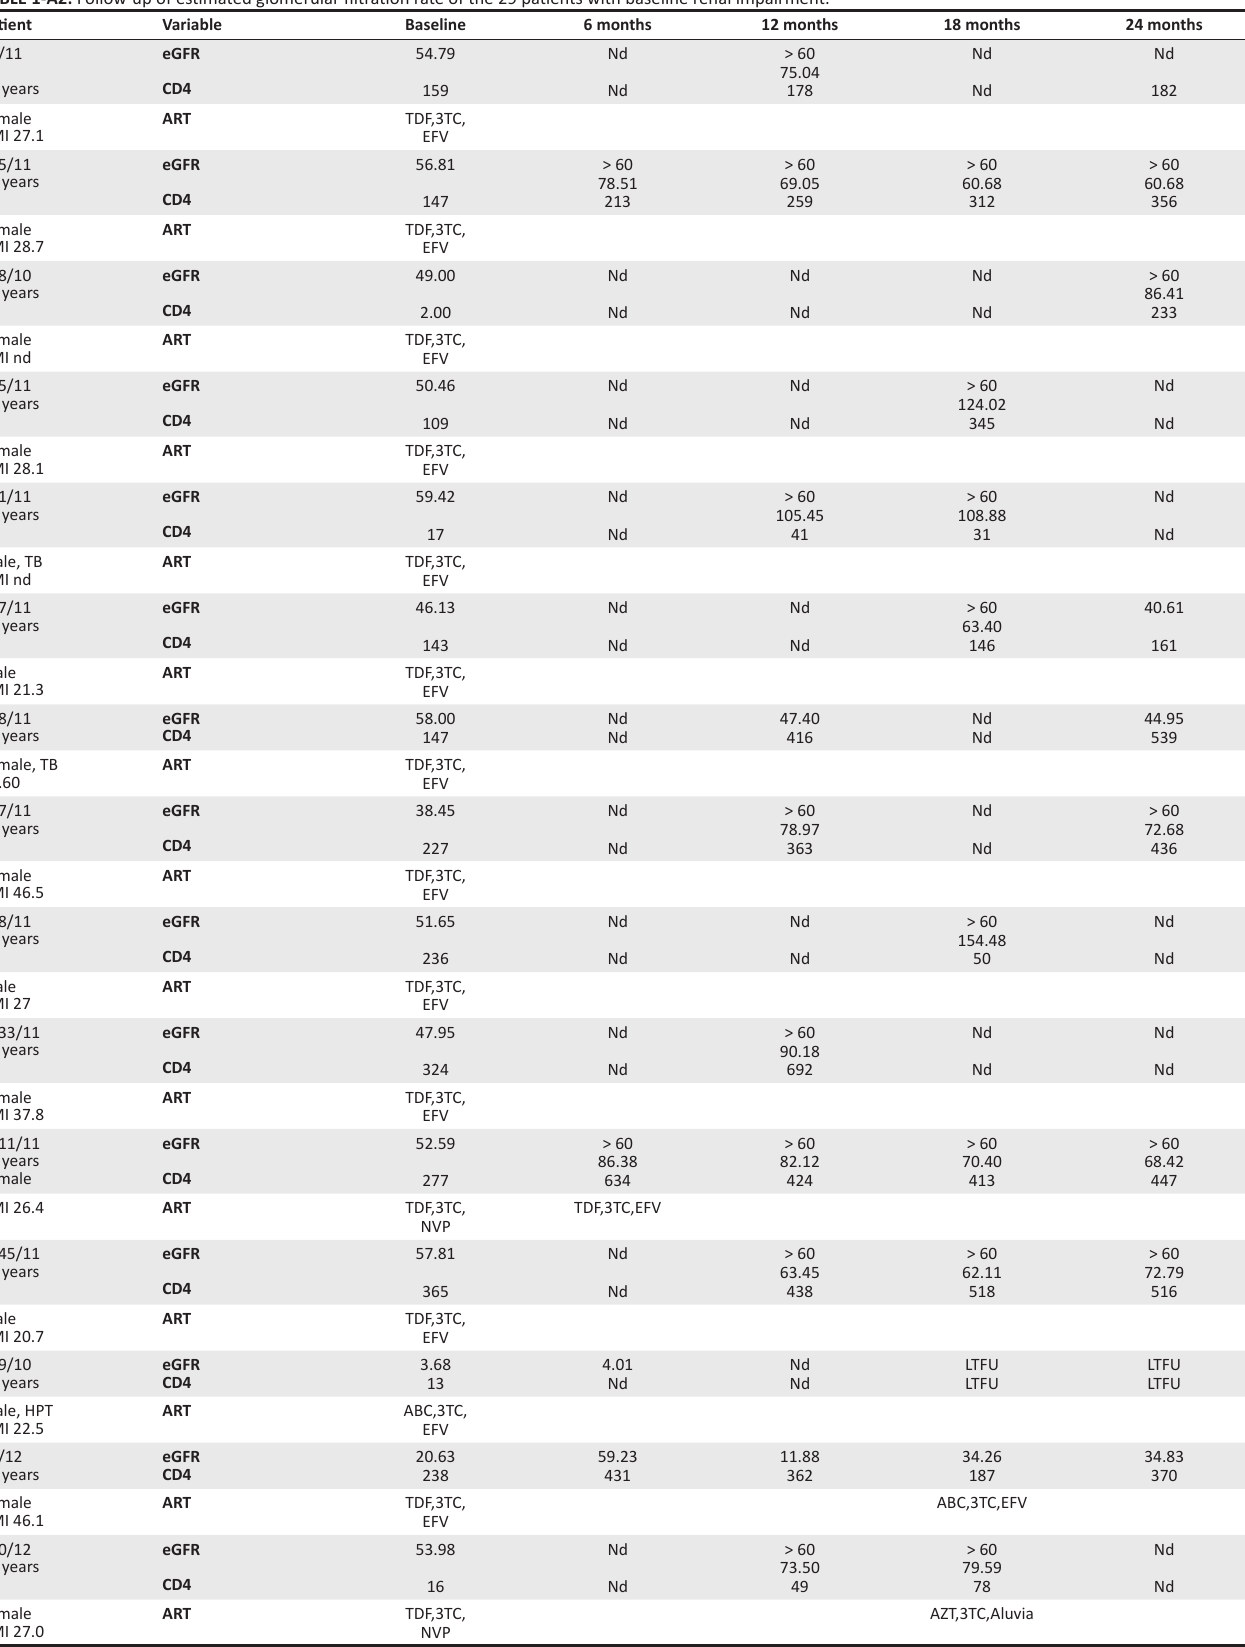
TABLE 1-A2: Follow-up of estimated glomerular filtration rate of the 29 patients with baseline renal